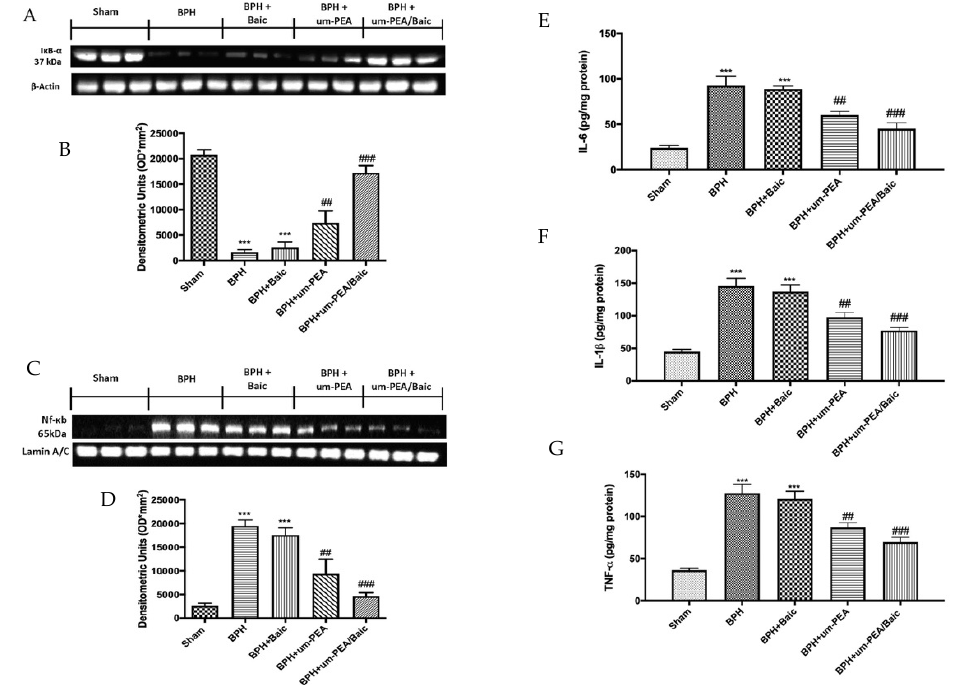
Figure 5. Effect of um-PEA/Baic on inflammation pathway . Western blots and densitometric analysis of I κ B- α ( A,B ) and NF- κ B ( C,D ). IL-6 ( E ), IL-1 β ( F ) and TNF- α ( G ) levels. A demonstrative blot of lysates with a densitometric analysis for all animals is shown. Values shown are means ± SEM of six animals in each group. *** p < 0.001 vs. sham; ## p < 0.01 vs. BPH group; ### p < 0.001 vs. BPH group.